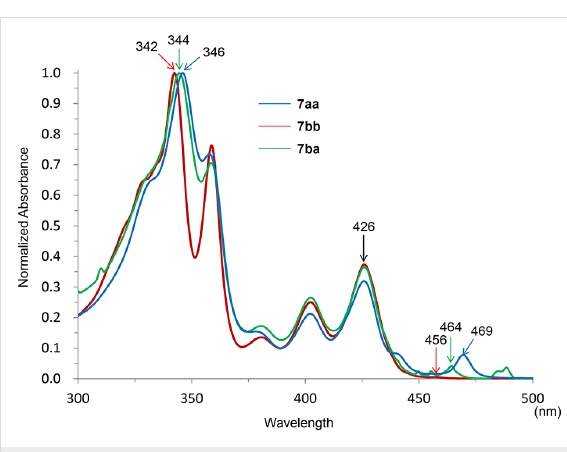
Figure 1: Normalized UV–vis absorption spectra of 7aa , 7bb , and 7ba .